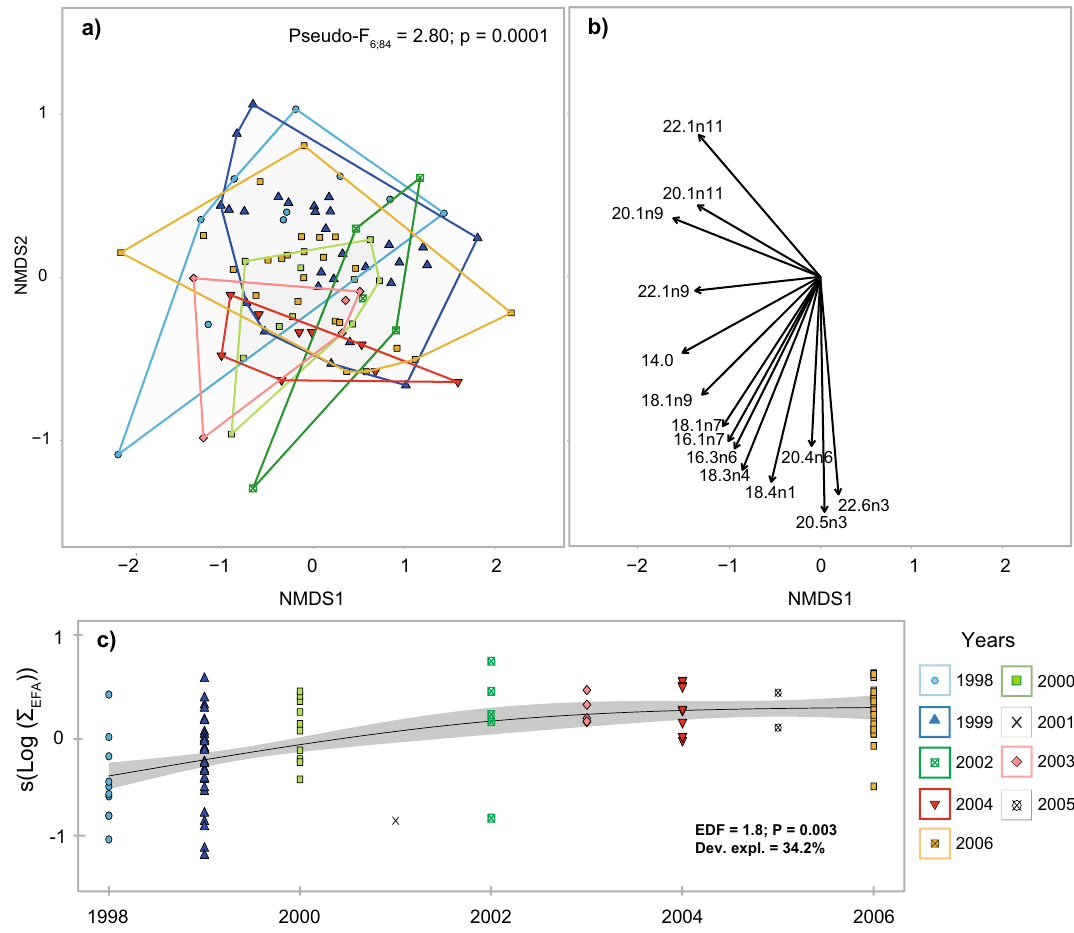
Figure 3. Multidimensional scaling (n-MDS) ordination in Euclidean space of (a) the fatty acid composition of fin whales, (b) fatty acids responsible for these groupings (Pearson correlations), and (c) long-term trend in the proportion of major essential fatty acids (Sum of 20:5n3, 22:6n3 and 20:4n6). nMDS calculations were based on the extended dietary fatty acid subset (n = 39). Avg. = Population average. Detailed interactive and static 3D n-MDS is also available in the Supplementary Fig. S2 online and in Mendeley data repository (https:// doi. org/ 10. 17632/ 6nxhj